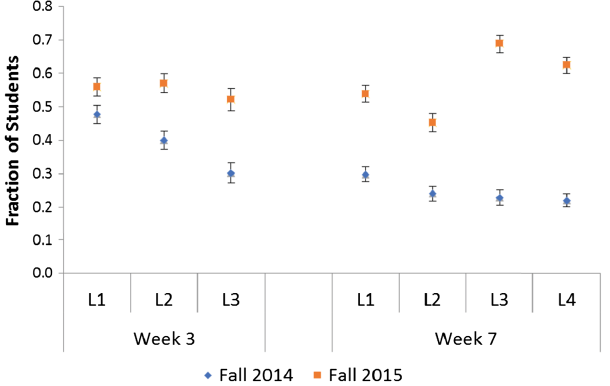
FIG. 4. Solution viewing: The fraction of students who watched over half of the solution videos to their missed problems, separated by levels in two unchanged weeks from 2014 to 2015.